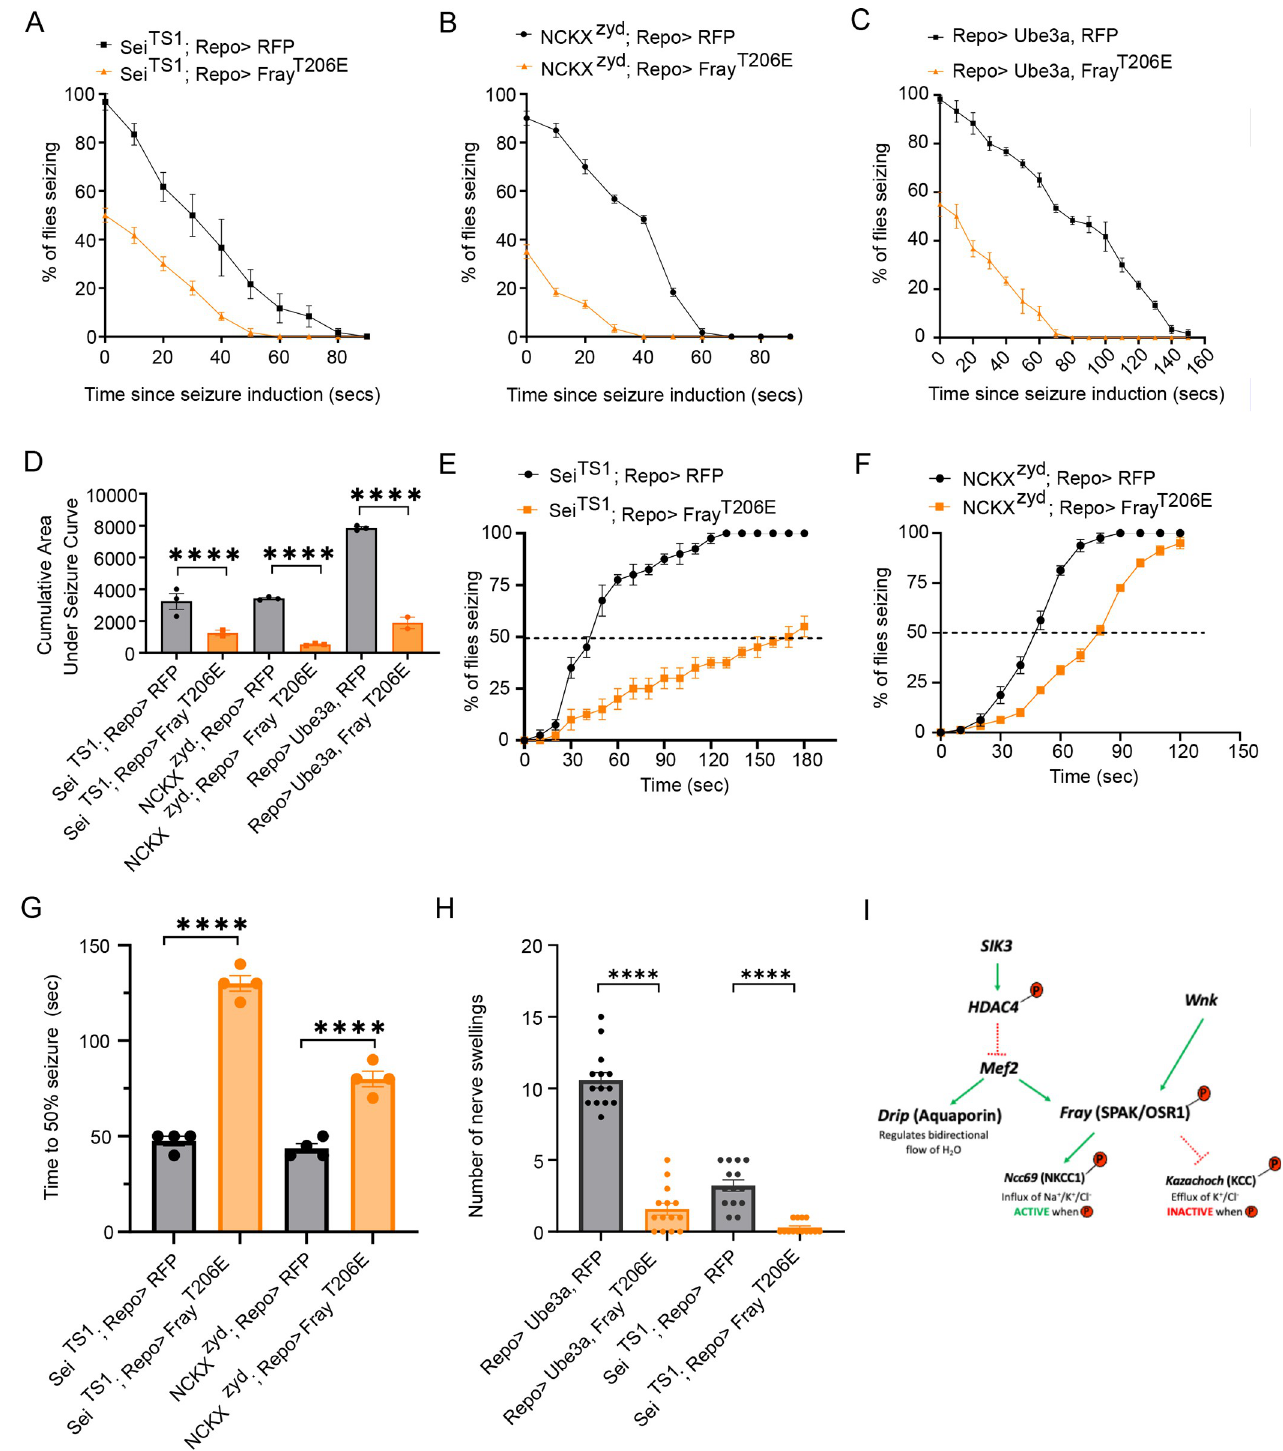
Fig 4. Activating Fray is sufficient to suppress seizure behavior. (A) Time course of heat shock induced seizure behaviors. The pan glial driver Repo-Gal4 was used to express a control transgene, UAS-LexA RNAi (Sei TS1 ;Repo > ), or constitutively active Fray (Sei TS1 ;Repo > Fray T206E ). After seizure induction, the number of flies seizing were recorded every 10 seconds and plotted as a percentage of seizing flies. n � 3 groups of 10–20 flies per genotype per time point. (B) Time course of heat shock induced seizure behaviors. The pan glial drive Repo-Gal4 was used to express a control transgene, UAS-LexA RNAi (NCKX zyd Repo > ), or constitutively active Fray (NCKX zyd ;Repo > Fray T206E ). After seizure induction, the number of flies seizing were recorded every 10